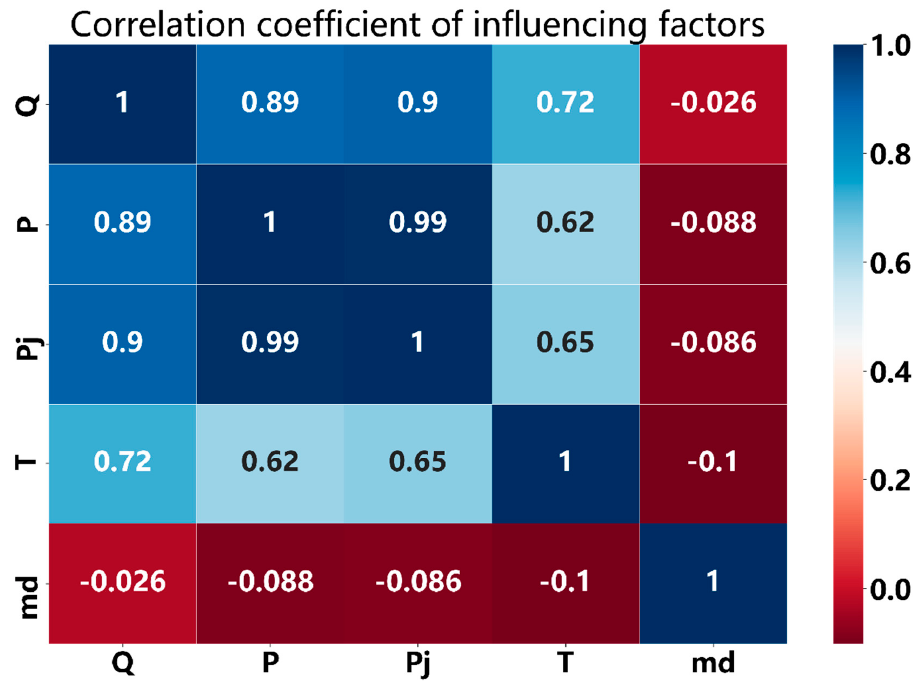
Figure 2. Correlation coefficient analysis of influencing factors.